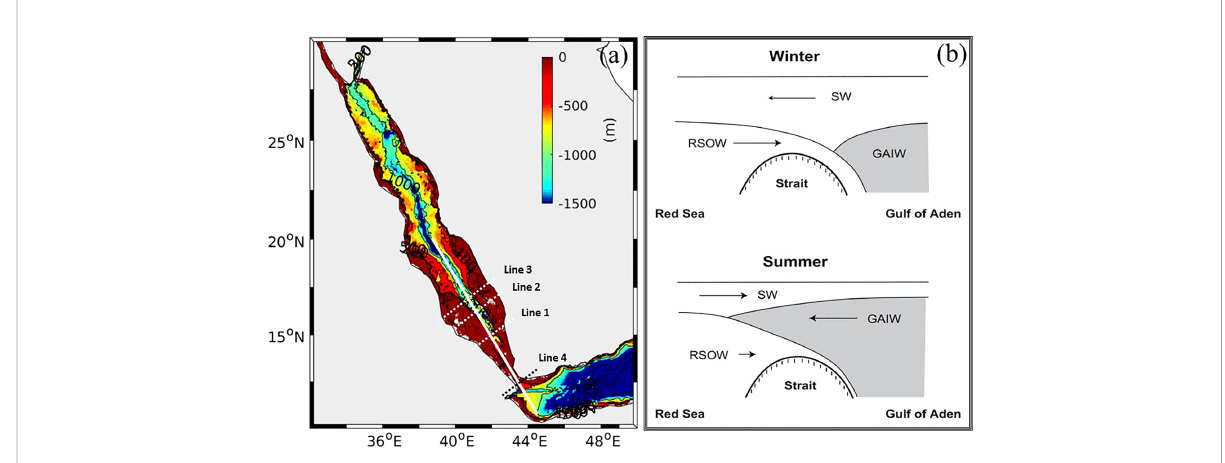
FIGURE 1 (A) Bathymetry of the Red Sea. The white line indicates the along-axis transect of the summer intrusion of GAIW and dashed lines represent the cross-sections; (B) the schematic fi gure of the strati fi cation structure at the BAM strait in Winter (upper panel) and Summer (lower panel). Panel (B) is adopted from Siddall et al.